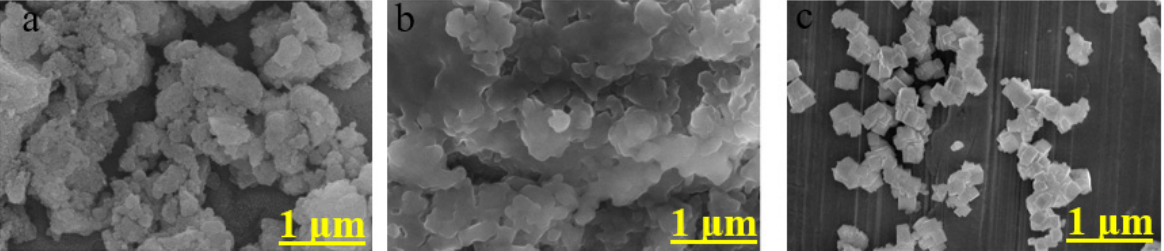
Figure 2. SEM image of the ( a ) SF[Fe-Tol-Co], ( b ) SF[Fe-Tol-Ni], ( c ) SF[Fe-Tol-Mn].